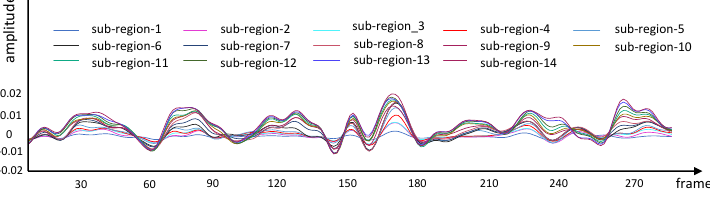
Figure 1. The raw chrominance signals from 14 different sub-regions, which are highly